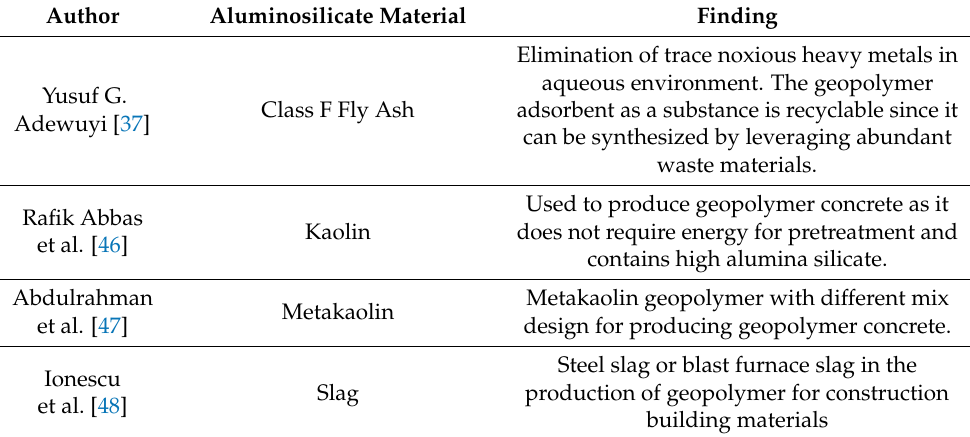
Table 1. Aluminosilicate materials used in the recent research on geopolymers.